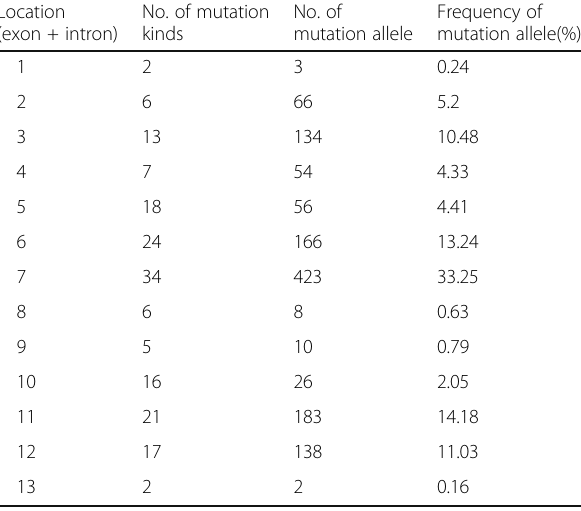
Table 2 Exon Distribution and allelic frequencies of PAH gene Location No. of mutation (exon + intron) kinds